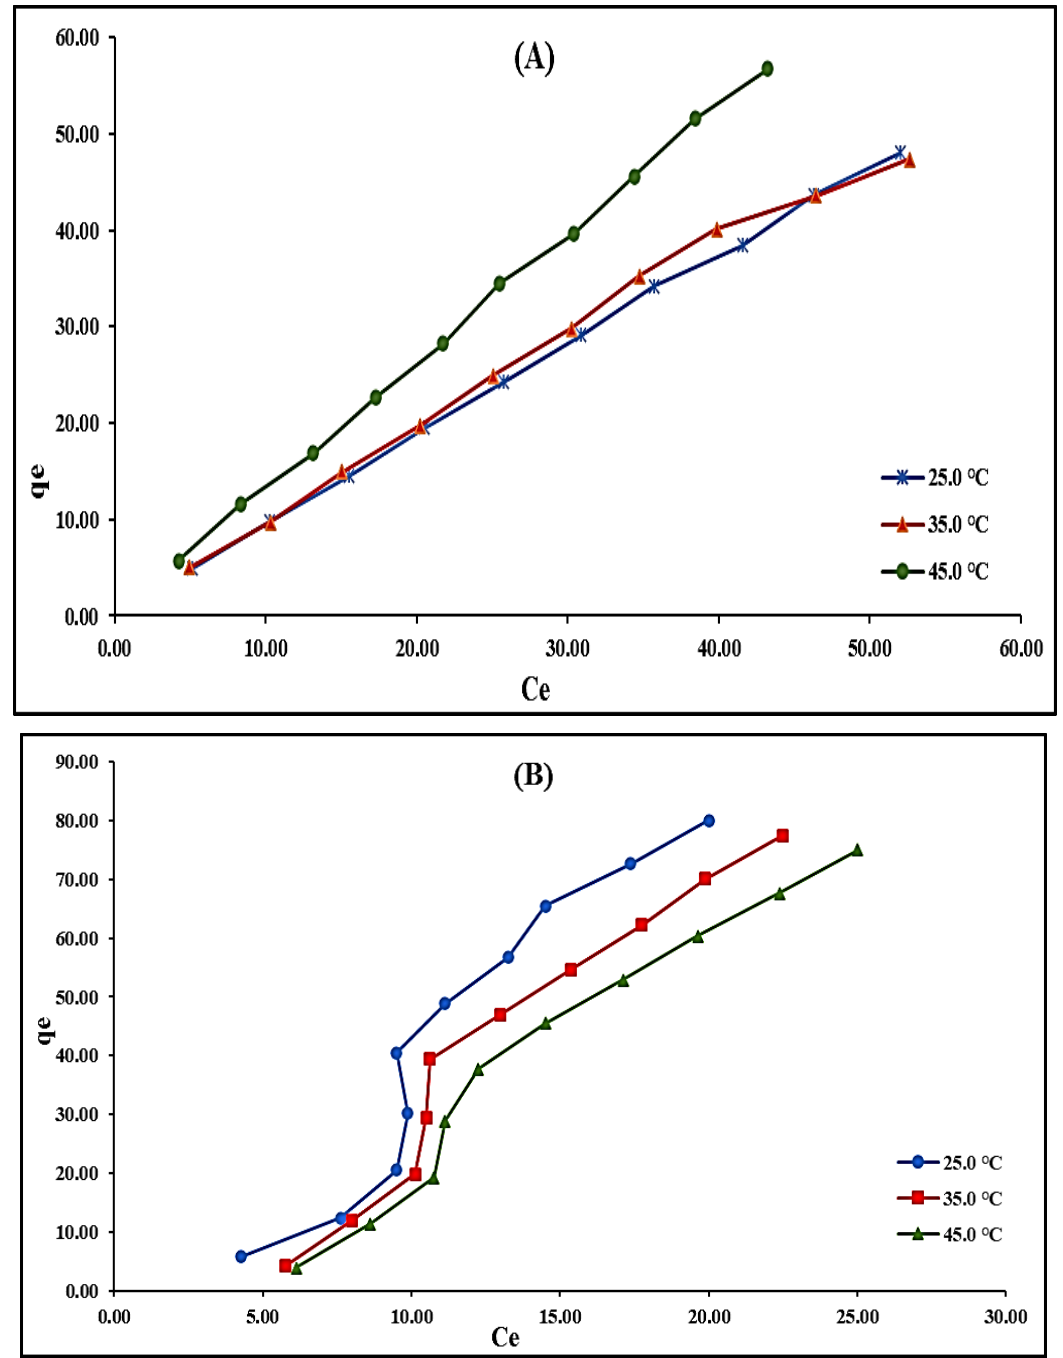
Figure 11. Adsorption isotherm of ( A ) U(VI) and ( B ) Th(IV) by CCsMFO nanocomposite at pH 3.0.